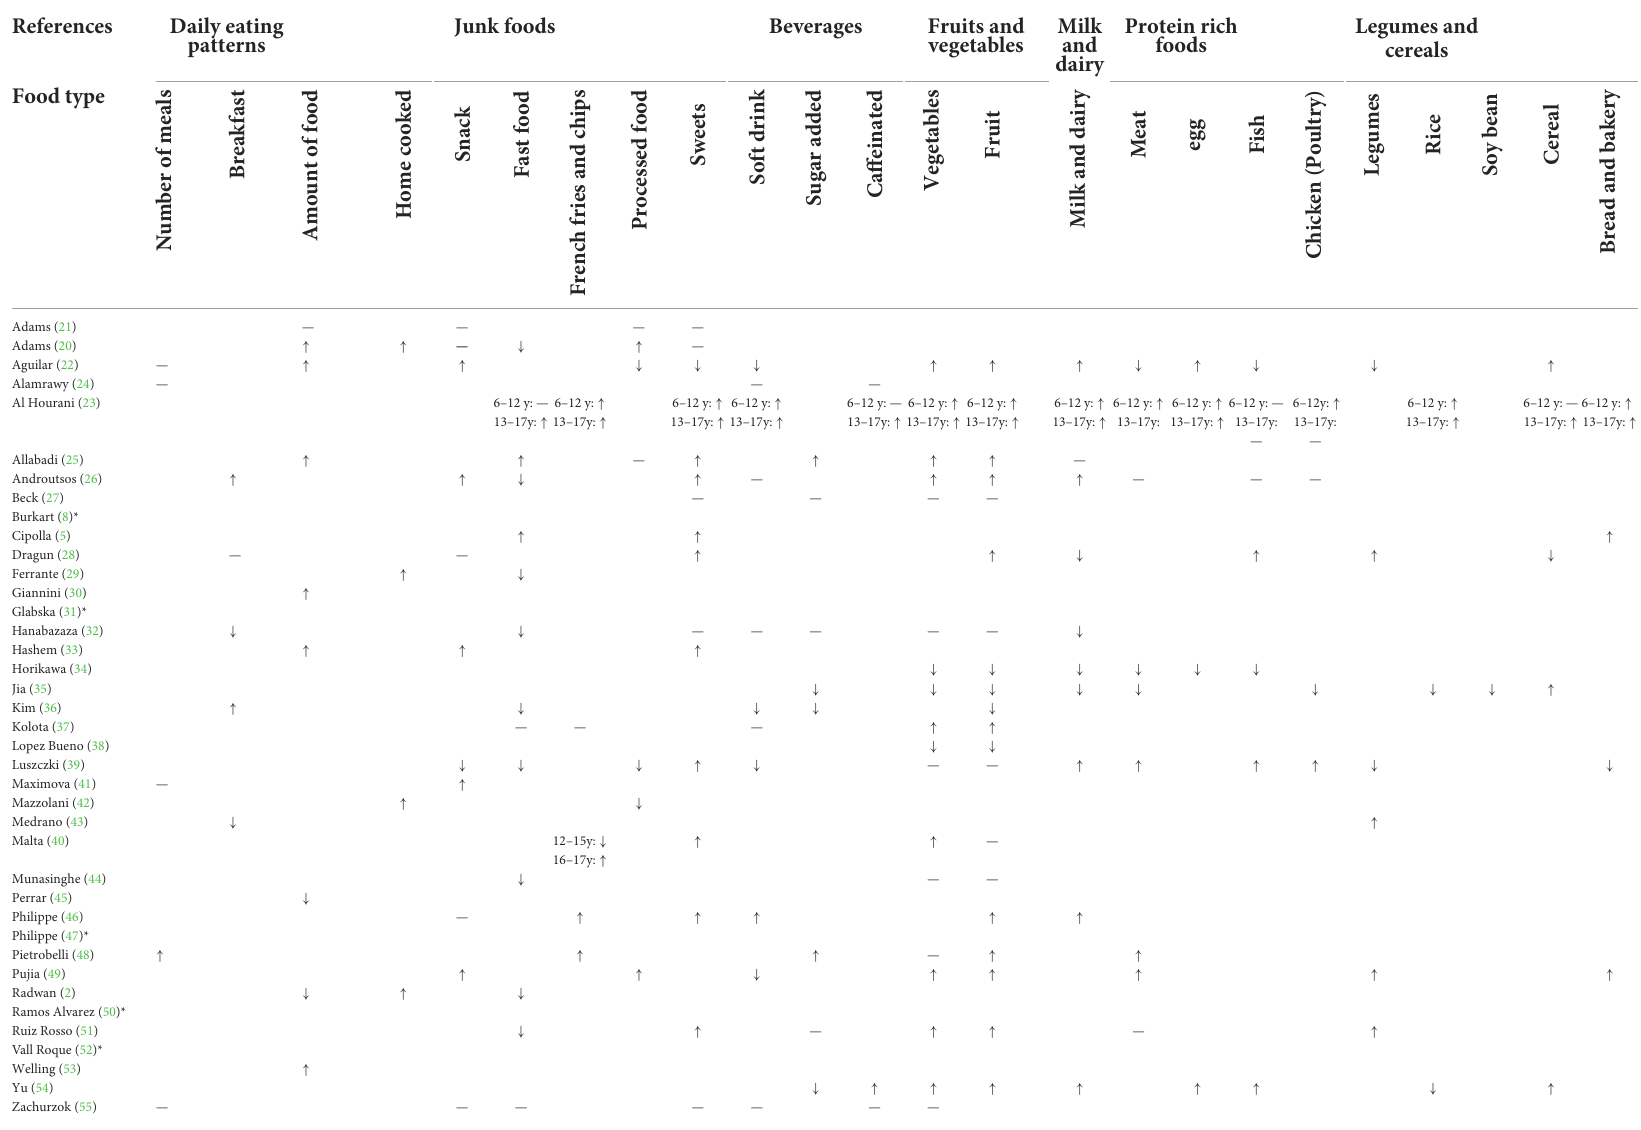
TABLE 2 Observed changes in eating habits in seven categories due to COVID-19 lockdowns in the 39 included studies.